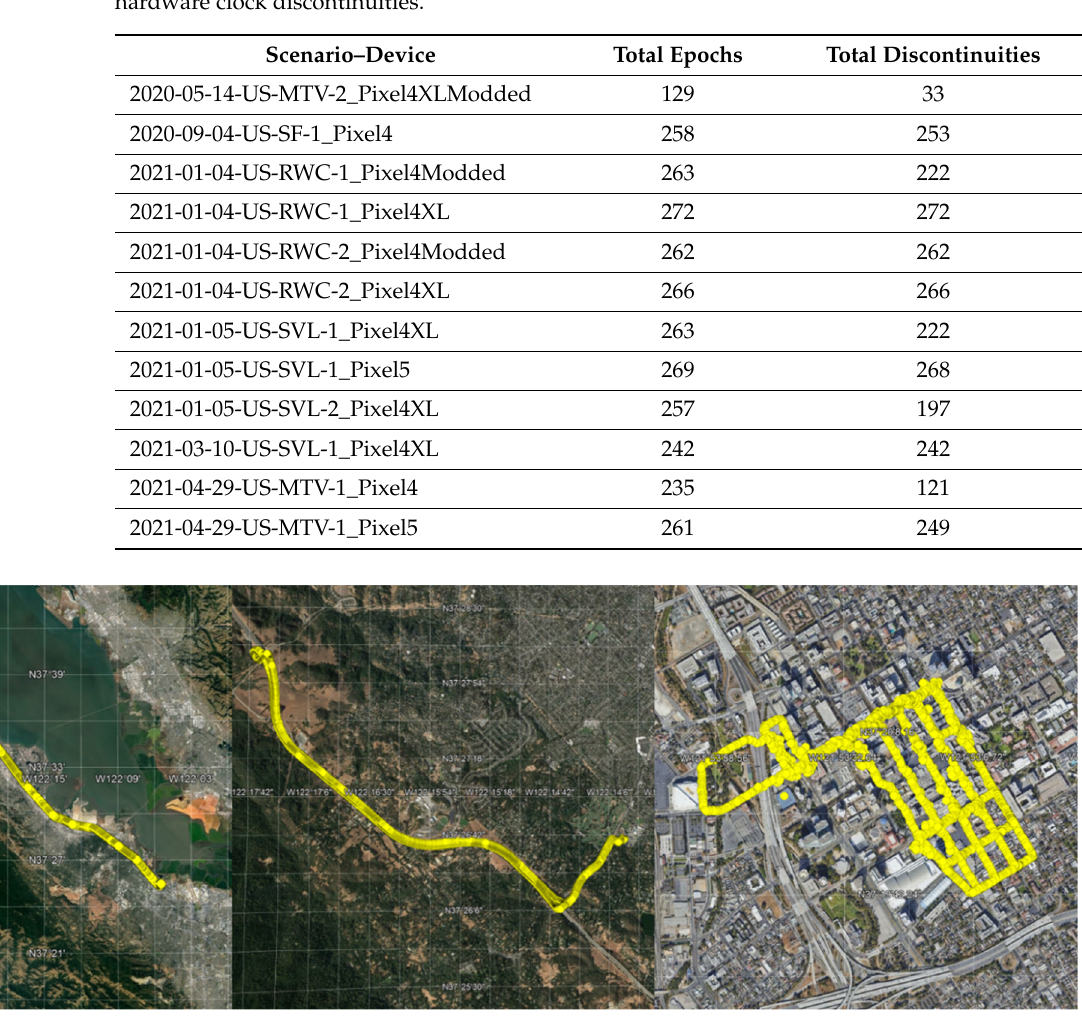
Figure 2. Illustration of the different scenarios: Highway ( left ), Street ( middle ), and Urban Canyon ( right ). Each scenario is representative of various GNSS environments: open-sky, mixed, and multipath.